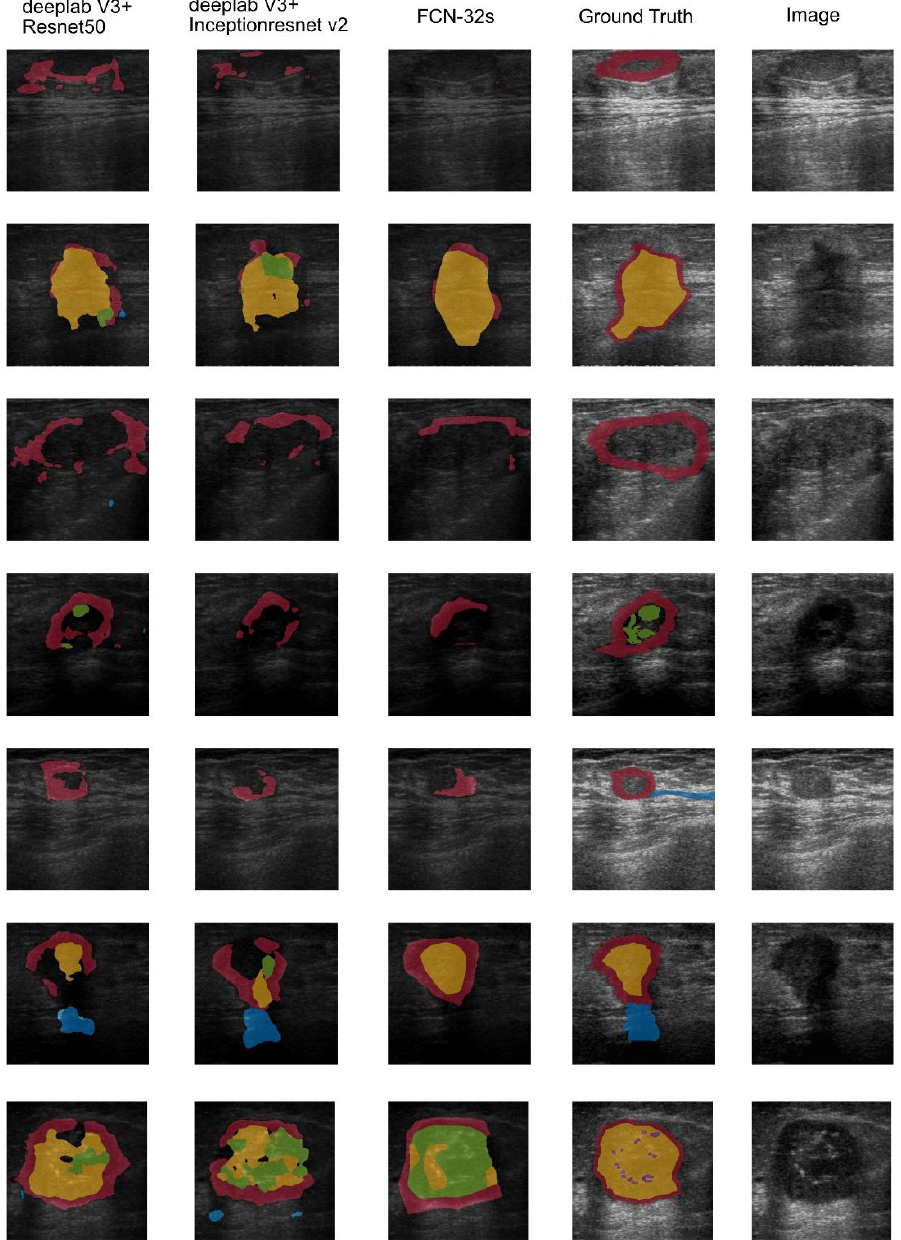
Figure 9. The sample of semantic segmentation visualisation for the malignant tumour ultrasound images after applying DeepLab v3+, and compared to FCN-32s. The sample US image and corresponding ground truth are shown in the two columns on the far right. The visualisation result from the first column on the left to the right: DeepLab v3+ with ResNet-50, DeepLab v3+ with Inception-ResNet-v2, FCN-32s. The semantically segmented regions based on BI-RADS lexicons are filled in the image with different colours. Red: angular margins, Green: hypoechogenicity, Yellow: taller-than-wide, Blue: duct extension, Navy Blue: shadowing, Purple: micro-lobulation. In addition to its performance in semantic segmentation, two other significant benefits of DeepLab v3+ with ResNet-50 over FCN-32s were related to the training resource and exclusion time. Table 2 also presents the average training time in each fold. DeepLab v3+ with ResNet-50 required 130.74 min, and FCN-32s required 163.13 min. In